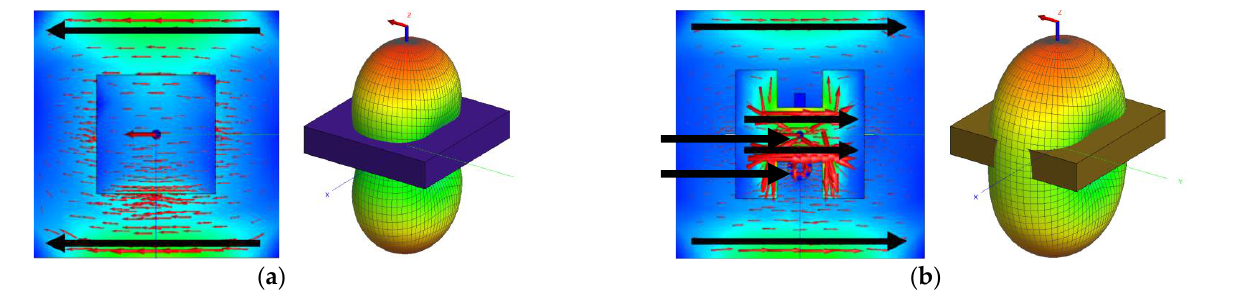
Figure 8. Scattering characteristic current distribution and far−field patterns comparison at 4.4 GHz.